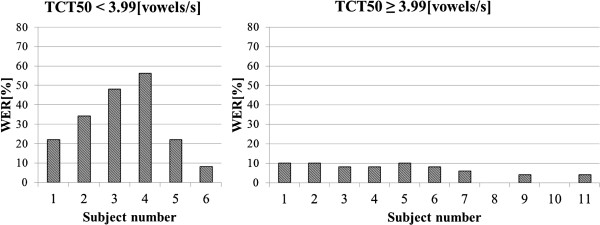
Average WER achieved by the elderly listeners for input speech with ROS equal to ROSmean4.